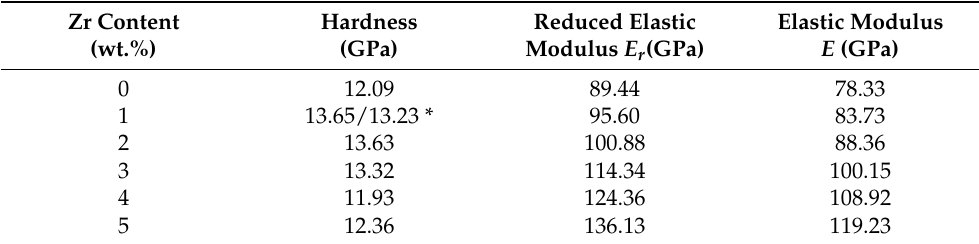
Table 1. Material properties obtained from nanoindentation simulation of Nb-Zr under various Zr contents at 296 K.